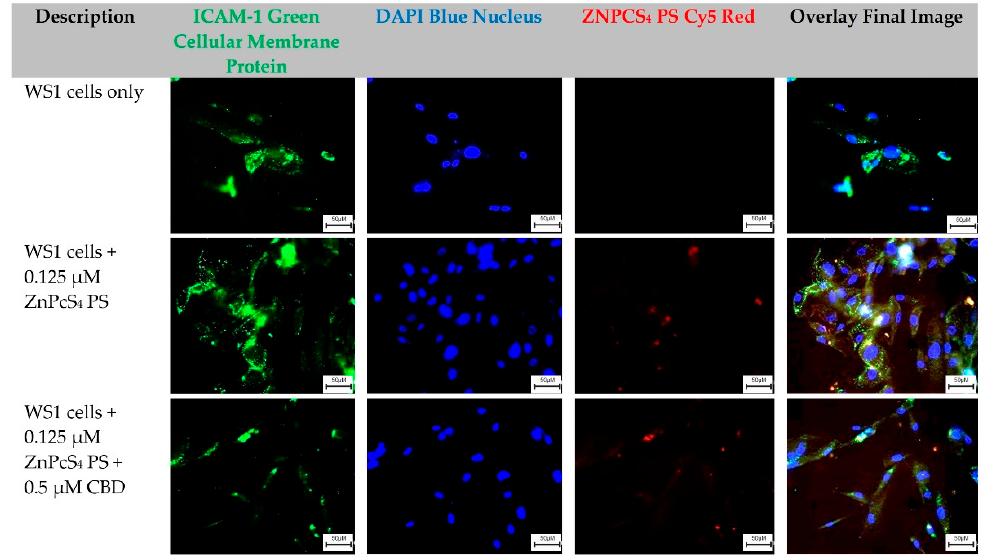
Figure 4. Subcellular localization comparison of various control and experimental groups of WS1 normal fibroblast cells, treated with singular and combinative ZnPcS 4 PS and/or CBD pre-irradiation; DAPI-stained nuclei (blue), ICAM-1 cellular membrane proteins (green), and Cy5 fluorescence from ZnPcS 4 PS subcellular localization (red) (40× magnification, 50 µM scale bar).